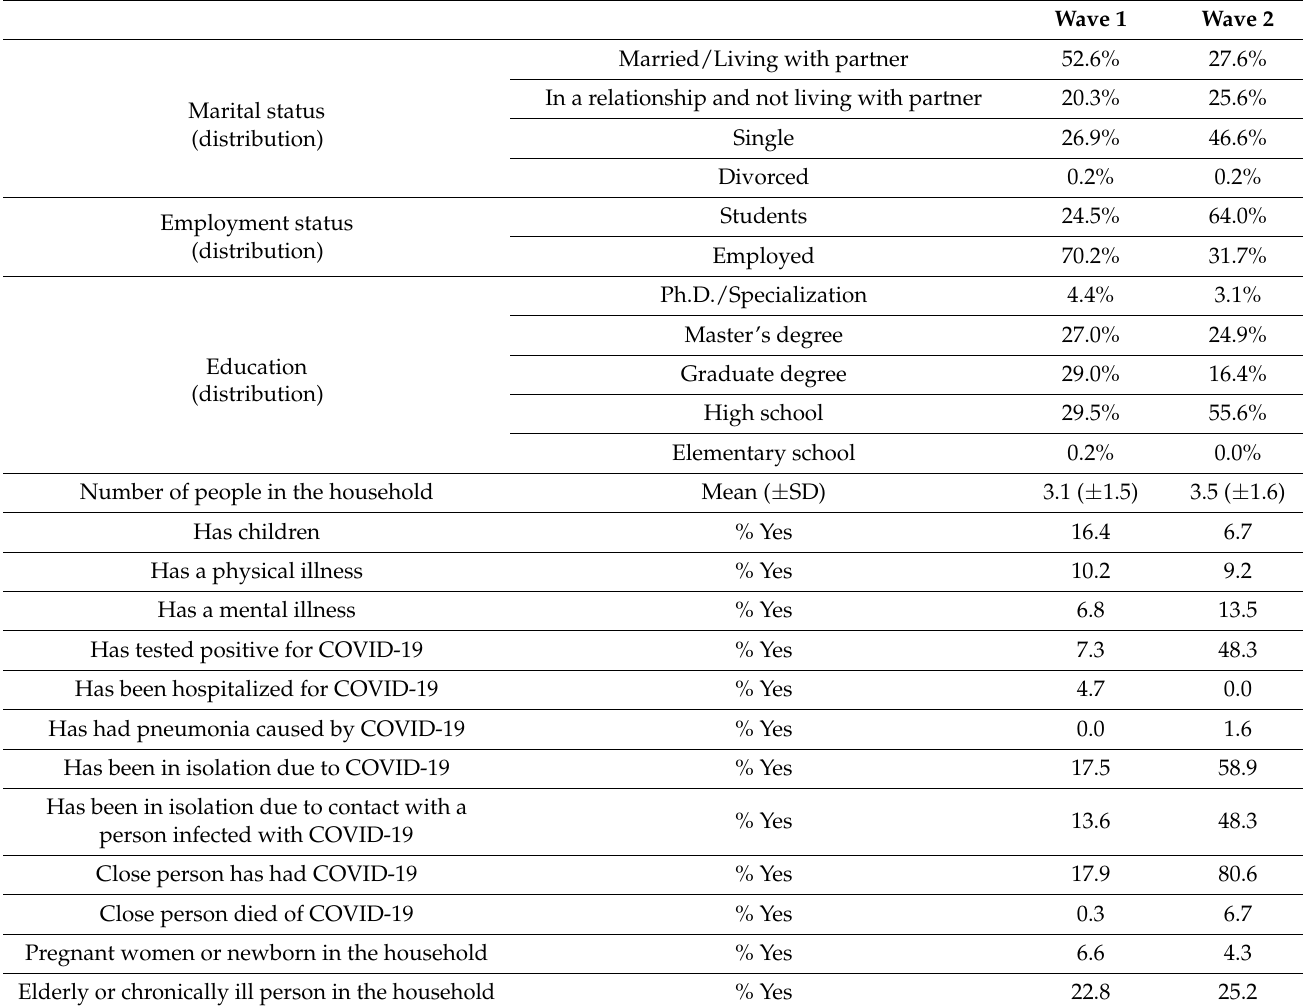
Table 1. Demographic, lifestyle, and COVID-19-related characteristics of the sample, in the first and the Omicron